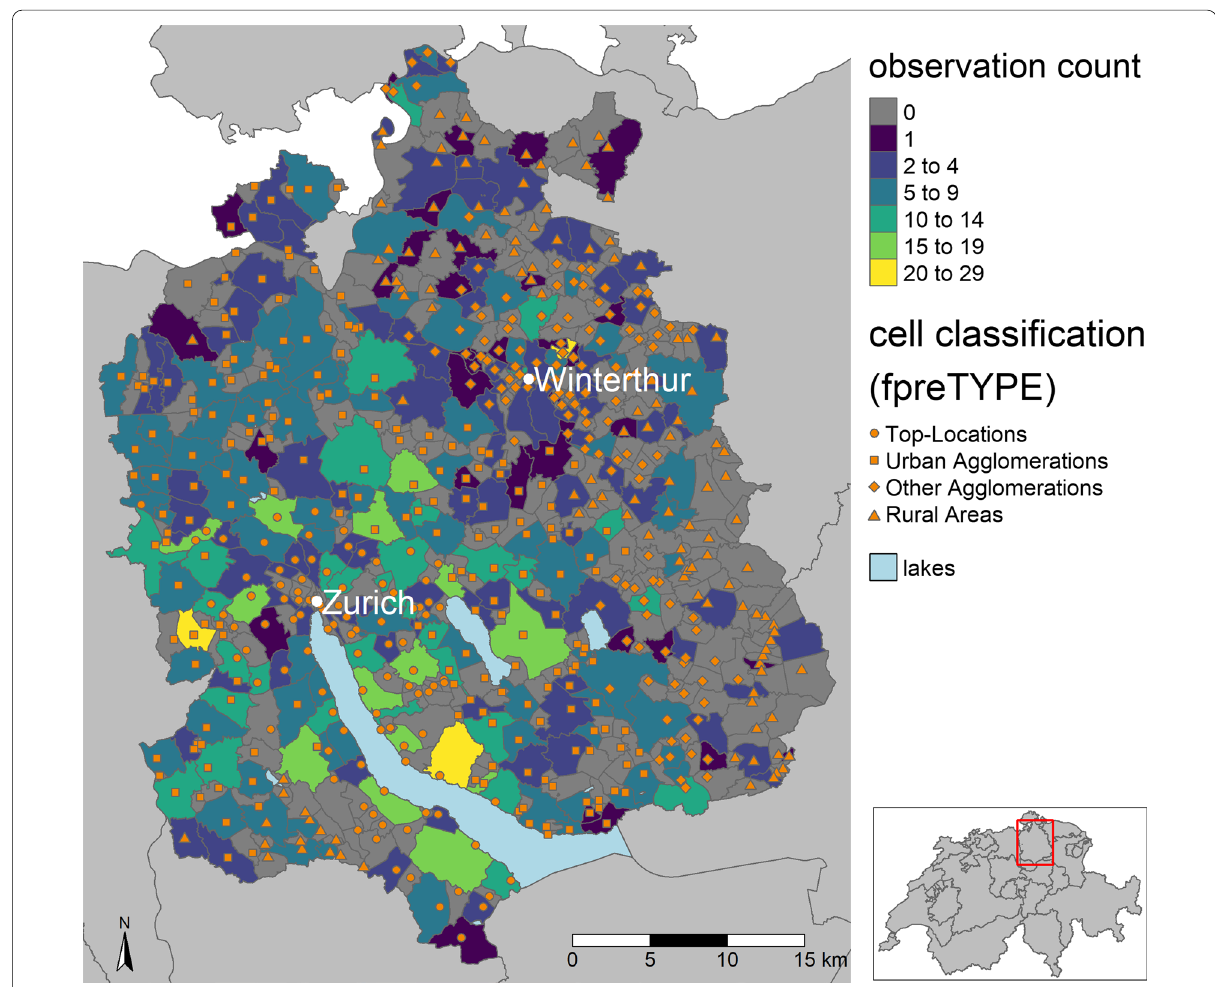
Fig. 4 Spatial distribution of observations and classification of locations within the Canton of Zurich. The Canton of Zurich is divided into 563 cells which are classified into types of location, depicted by the orange symbols. The number of observations within each cell is color-coded. The data set contains observations from 268 cells, where cells without any observations are colored